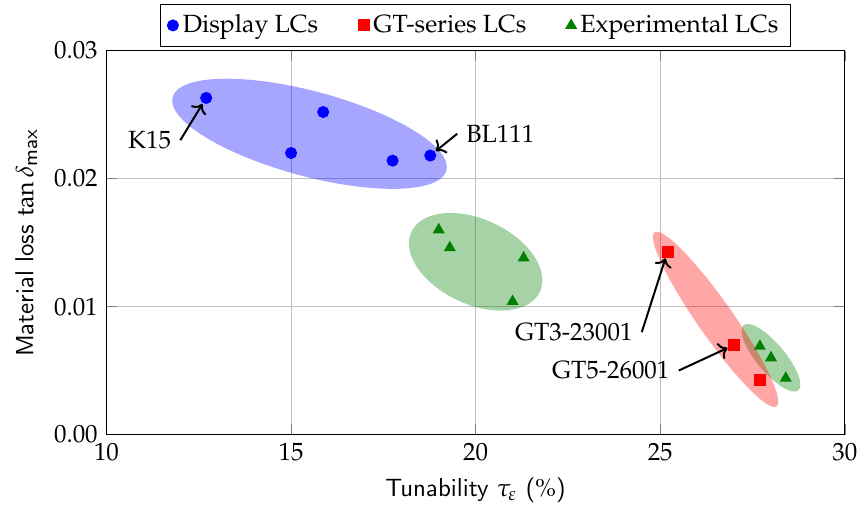
Table 2. Material properties of different LC mixtures at room temperature.